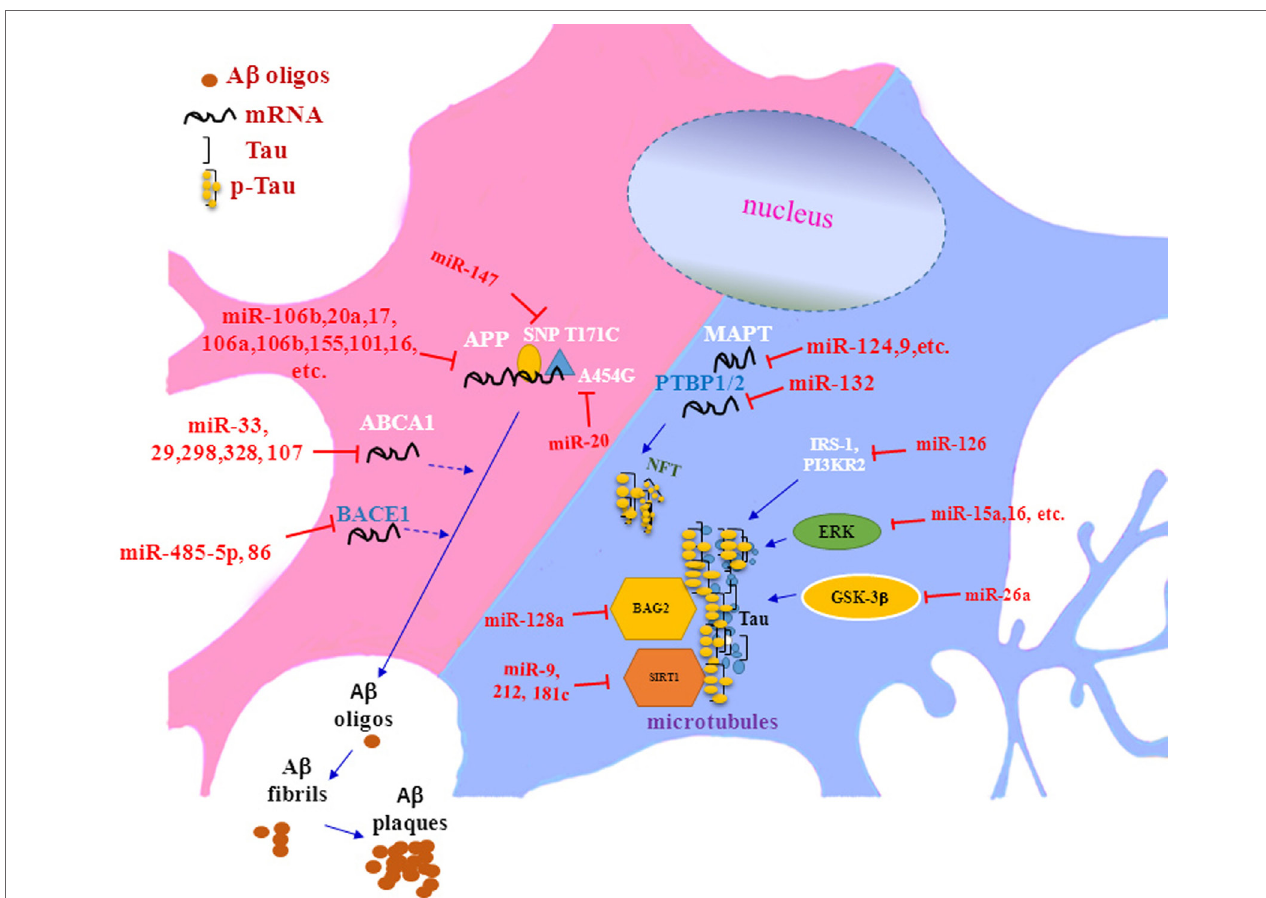
FiGURe 1 | The role of microRNAs in A β deposition and tau phosphorylation in pathogenesis of Alzheimer’s